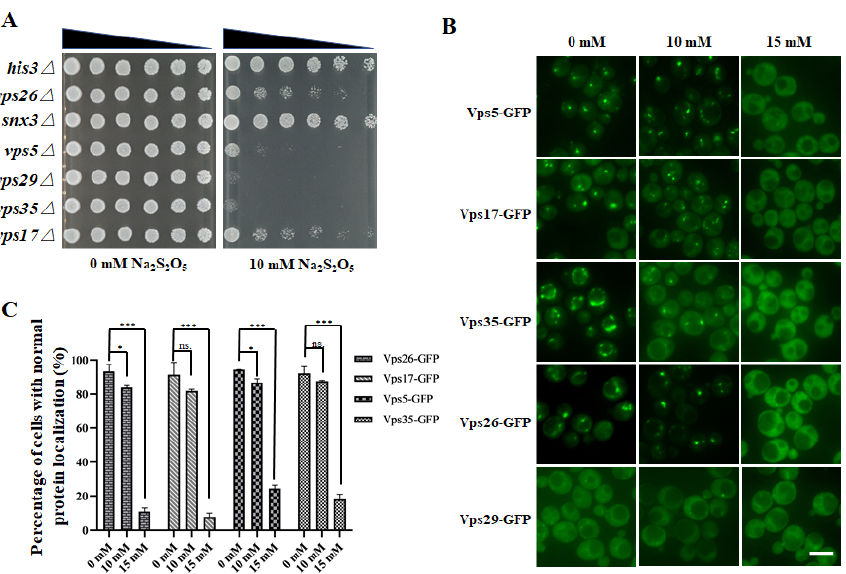
Figure 2. The retromer complex is important for yeast tolerance to sodium metabisulfite. ( A ) Spot-test assays of the SGA control strain ( MATa his3 ∆ ::kanMX4 ) and retromer deletion mutants. ( B ) Localization of the retromer complex proteins. Scale bar represents 5 μ m. ( C ) Quantifications of cells with normal protein localization. Three independent biological experiments were carried out, and for each replicate, a minimum of 200 cells were counted. The vertical axis represents the percentage of cells with normal protein localization, and the horizontal axis represents the different concentrations of Na 2 S 2 O 5 . Error bars indicate standard error. ns., no significant difference; ***, p < 0.001; *, p < 0.05; Student’s t -test.